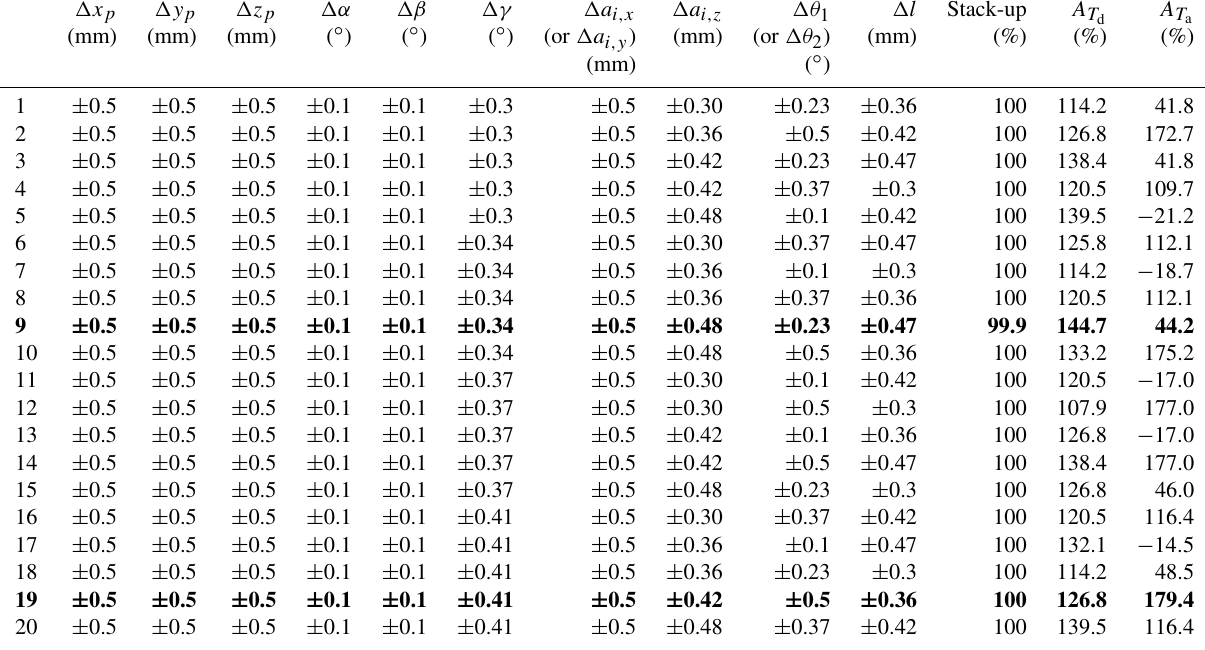
Table 11. Array U 20 (4 4 ) for responses with a sample size of 10 5 using Halton-set based MC simulation (part B). The solutions with the maximums of A T and A T are denoted in bold a d